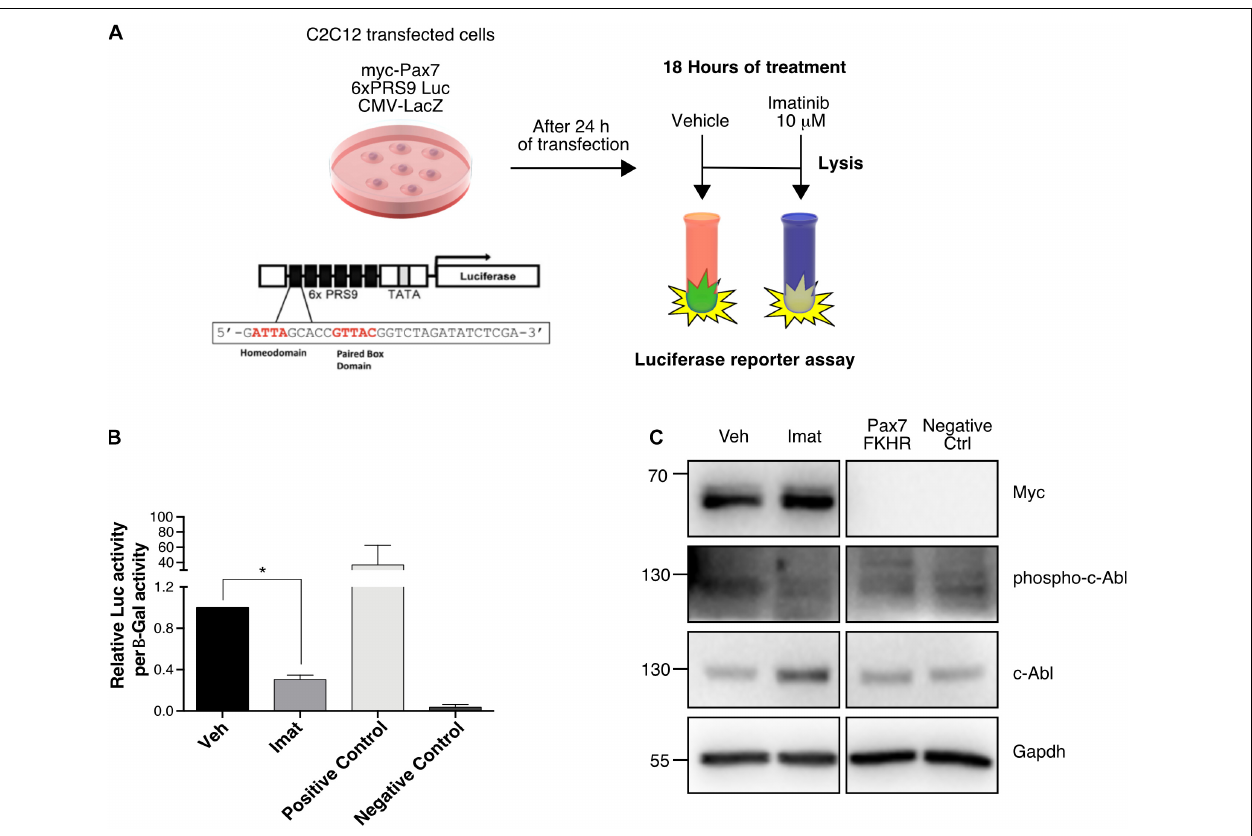
FIGURE 5 | c-Abl regulates Pax7 transcriptional activity. (A) Protocol for Reporter Assay. C2C12 cells were transfected with the indicated plasmids for 24 h. After that, treatment with DMSO as vehicle or Imatinib (10 µ M) was performed for 18 h. Finally, whole-cell lysates were collected, and luciferase and β -galactosidase activities were determined. (B) c-Abl inhibition decreases Pax7 transcriptional activity. Cells treated with Imatinib (mean: 0.305 ± 0.04) exhibits a significant decrease in Pax7 transcriptional activity in comparison with cells treated with vehicle (mean 1.00 ± 0.0), ( n = 4, * P -value < 0.05, Wilcoxon signed-rank test). (C) WB from reporter assay cells. We observed a decrease of c-Abl phosphorylation in cells treated with Imatinib corroborating the effectiveness of the